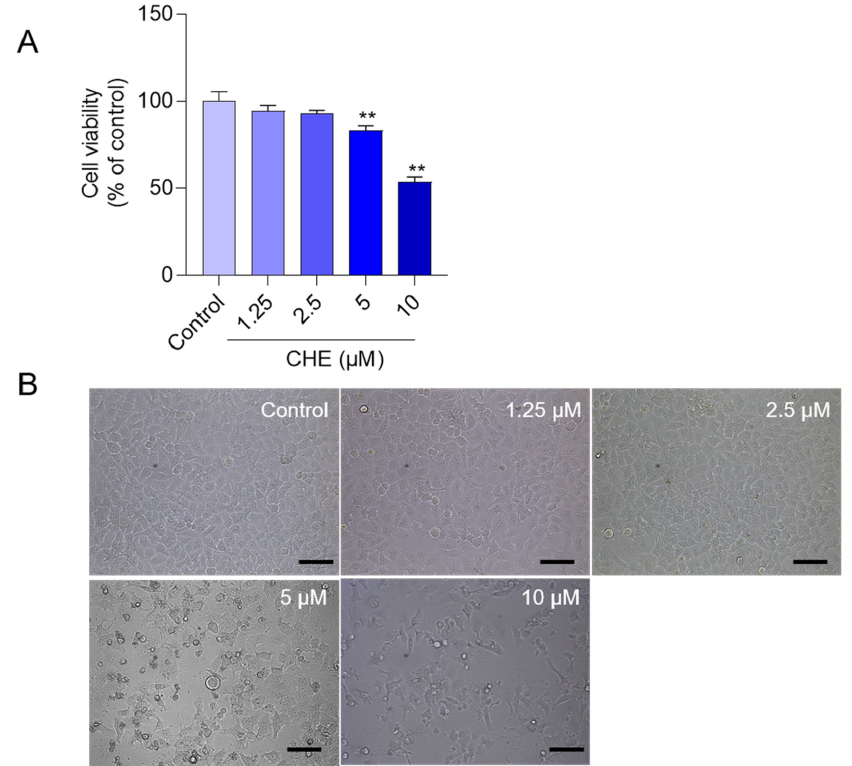
Figure 1. The cytotoxicity of chelerythrine (CHE) in HepG2 cells. ( A ) the effects of CHE treatment on the cell viability. HepG2 cells were treated with the different doses of CHE (at 1.25, 2.5, 5, and 10 μ M) for 24 h and cell viabilities were determined using the CCK-8 method. Data were presented as mean ± S.D. from four independent experiments ( n = 4). ( B ) the representative images of HepG2 cells treated with the different doses of CHE. Scale Bar = 50 μ m. ** p < 0.01, compared to the control group.